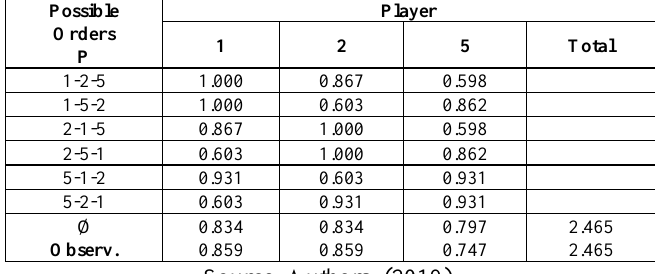
Table 10: Possible orders for 21-brood game, good years.